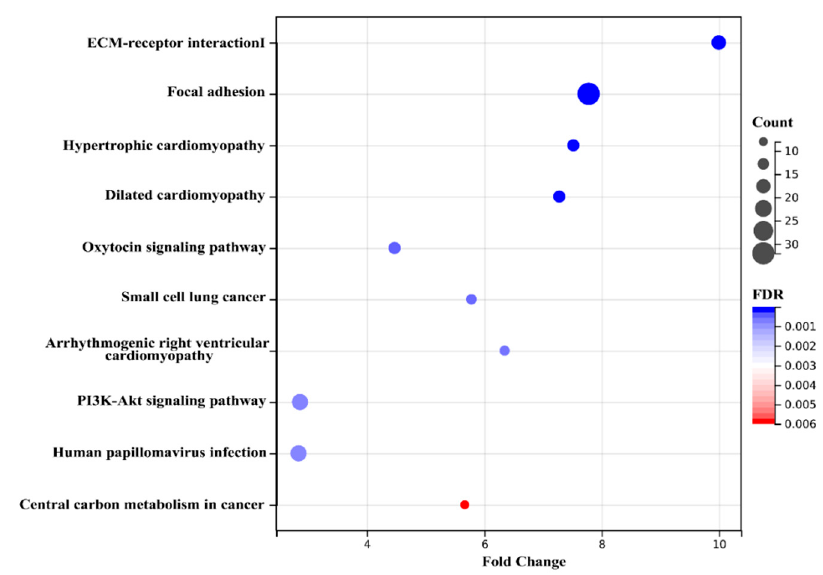
Figure 4. Top 10 enriched KEGG pathways of proteins in the liver. The false discovery rate (FDR) (lower and more intense rates in blue) represents the enriched degree. The size of the dots represents the number of proteins in this pathway.